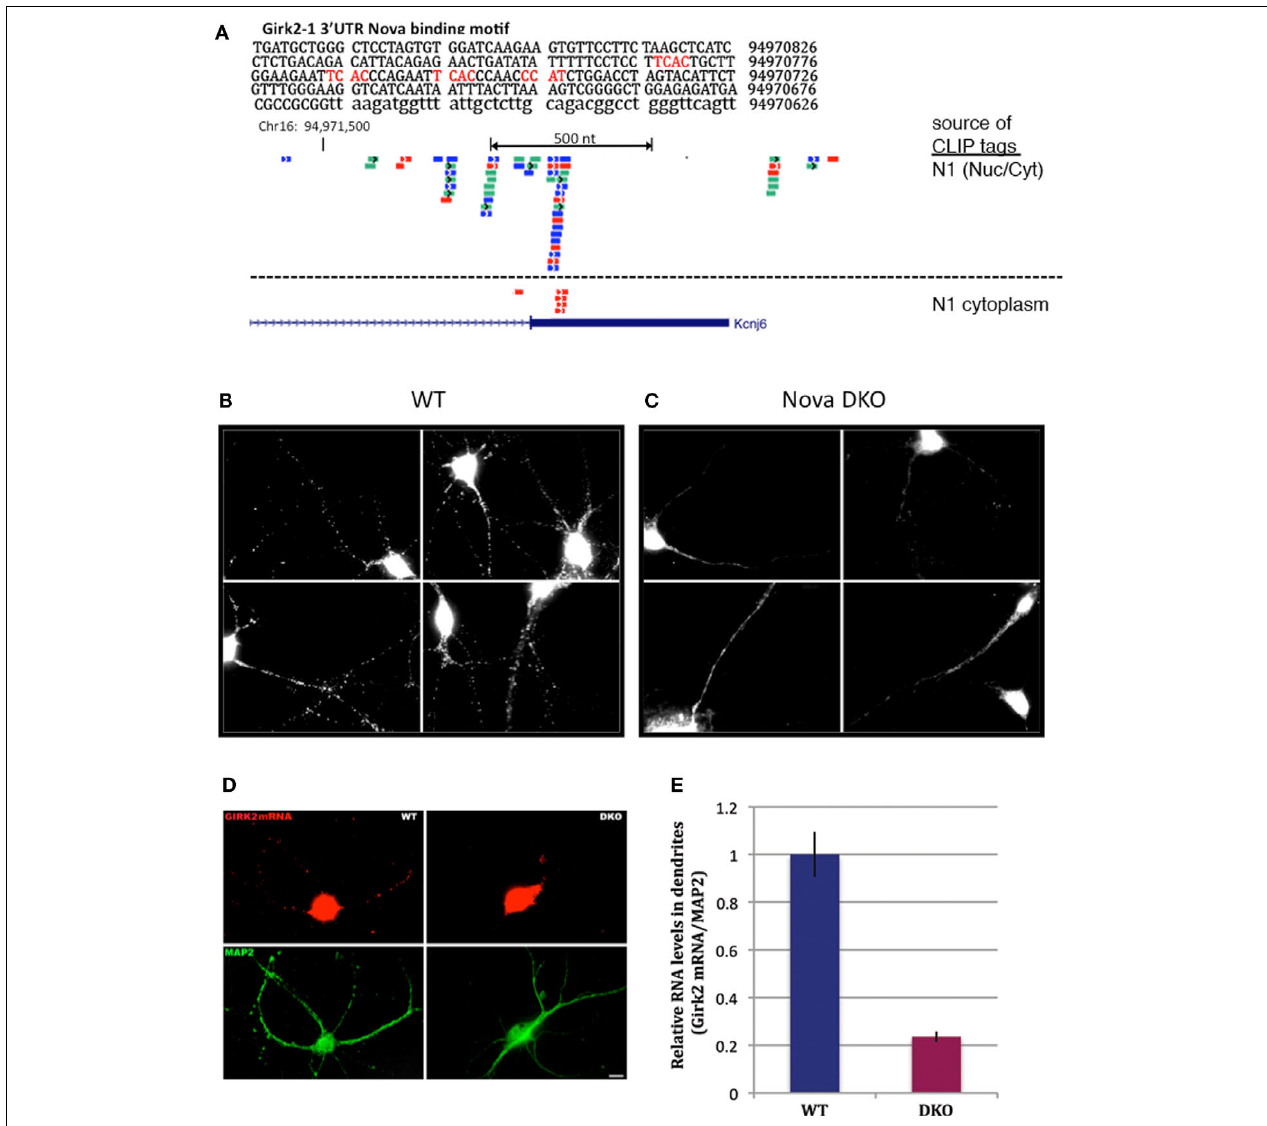
FIGURE 6 | Nova regulates localization of the CLIP target GIRK2-1 mRNA isoform in dendrites. (A) Location of Nova1 CLIP tags in the 3 ′ UTR of the GIRK2- 1 transcript. The RNA sequence of the GIRK2-1 3 ′ UTR in the region of the Nova binding site is shown, with YCAY elements highlighted in red. CLIP tags from mouse cortex (Nuc/Cyt) or cytoplasmic extracts of mouse brain (N1 cytoplasm) are shown separately. Nova tags are colored, with each color representing tags from a different mouse brain. Several other robust Nova CLIP target sites rich in YCAY elements were found in upstream sites, most notably in intron 2 ∼ 187,000nt upstream (see text). (B,C) Fluorescence ISH (FISH) using GIRK2-1 specifi c probes to detect mRNA in WT (B) or Nova DKO (C) primary cultured neurons obtained from E18.5 mouse cortex. No signal was seen with control ISH probes.